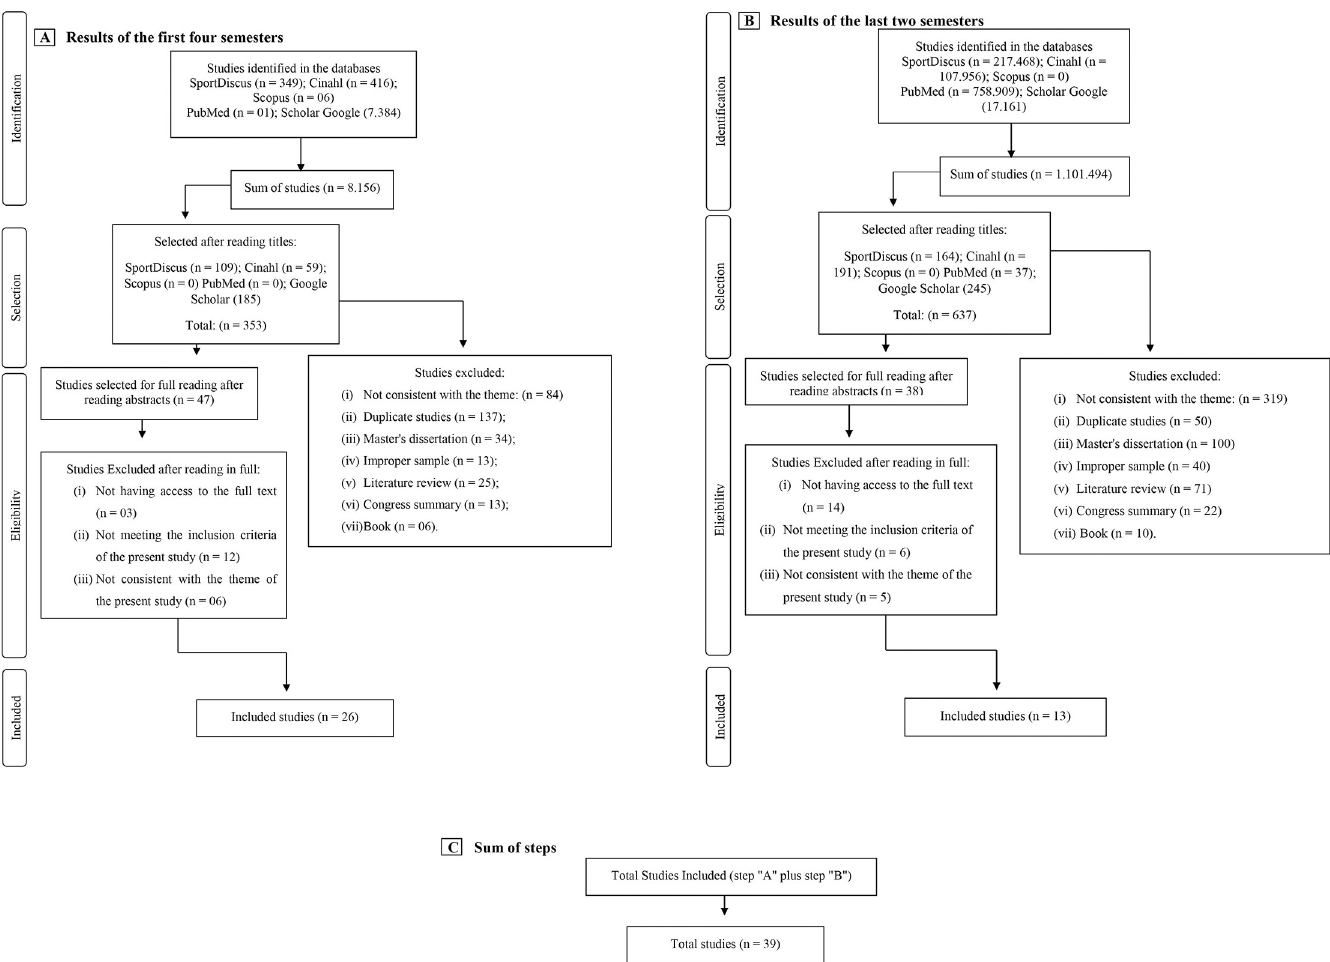
Fig 2. Flowchart of identification and selection of articles for systematic